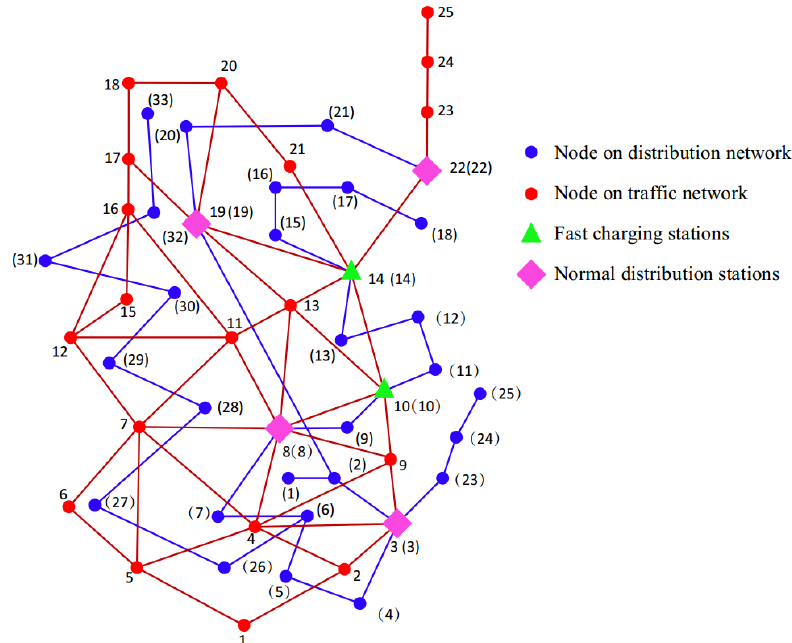
Figure 11. Graphical topology of the selected final planning scheme of the coupled 25-node traffic network and 33-node distribution network.